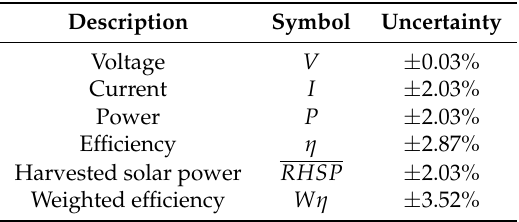
Table 7. Uncertainty of measurements and calculations.